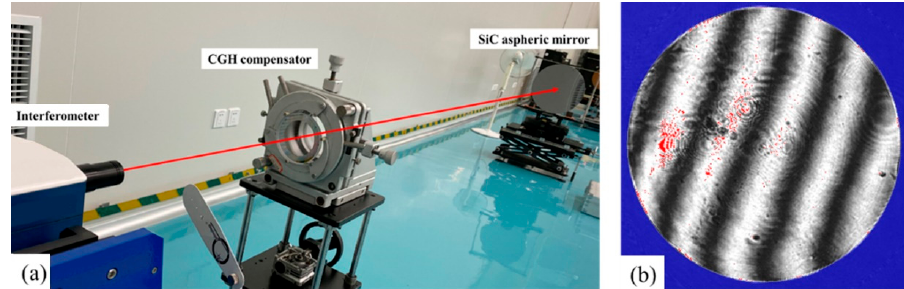
Figure 16. Design and fabrication of CGH compensation. ( a ) CGH design; ( b ) compensator.